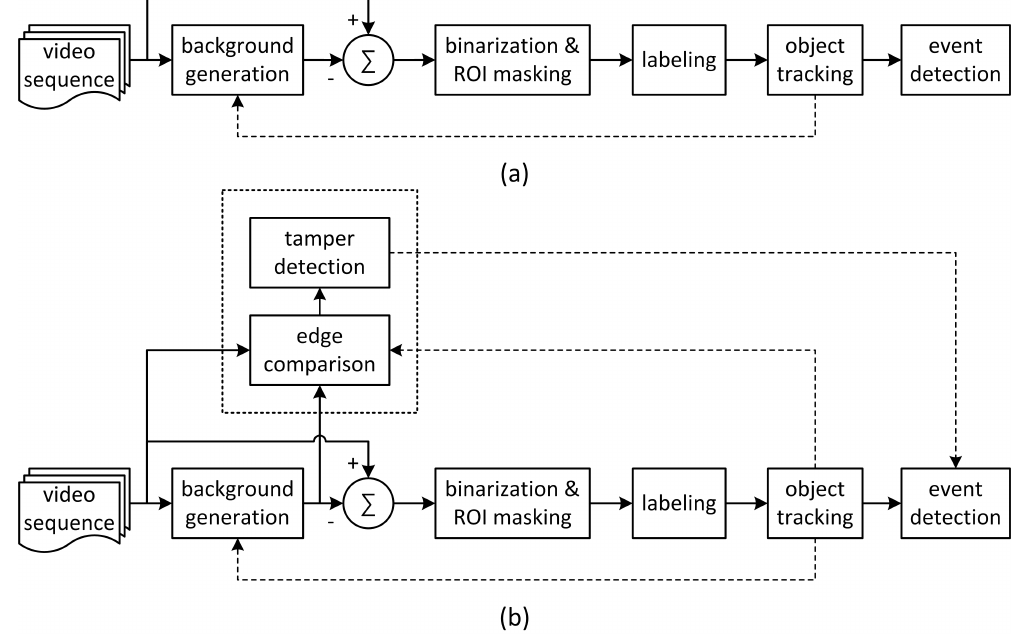
Figure 1. Camera tamper detection in video analytics systems: ( a ) video content analytics algorithm; ( b ) video content analytics algorithm with proposed tamper